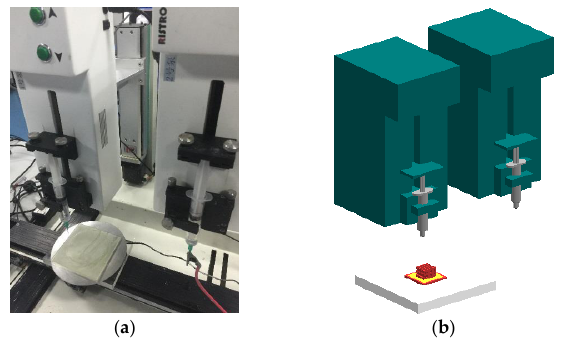
Figure 1. Bioprinting system: ( a ) image of actual system; ( b ) 3D schematic of the syringes.